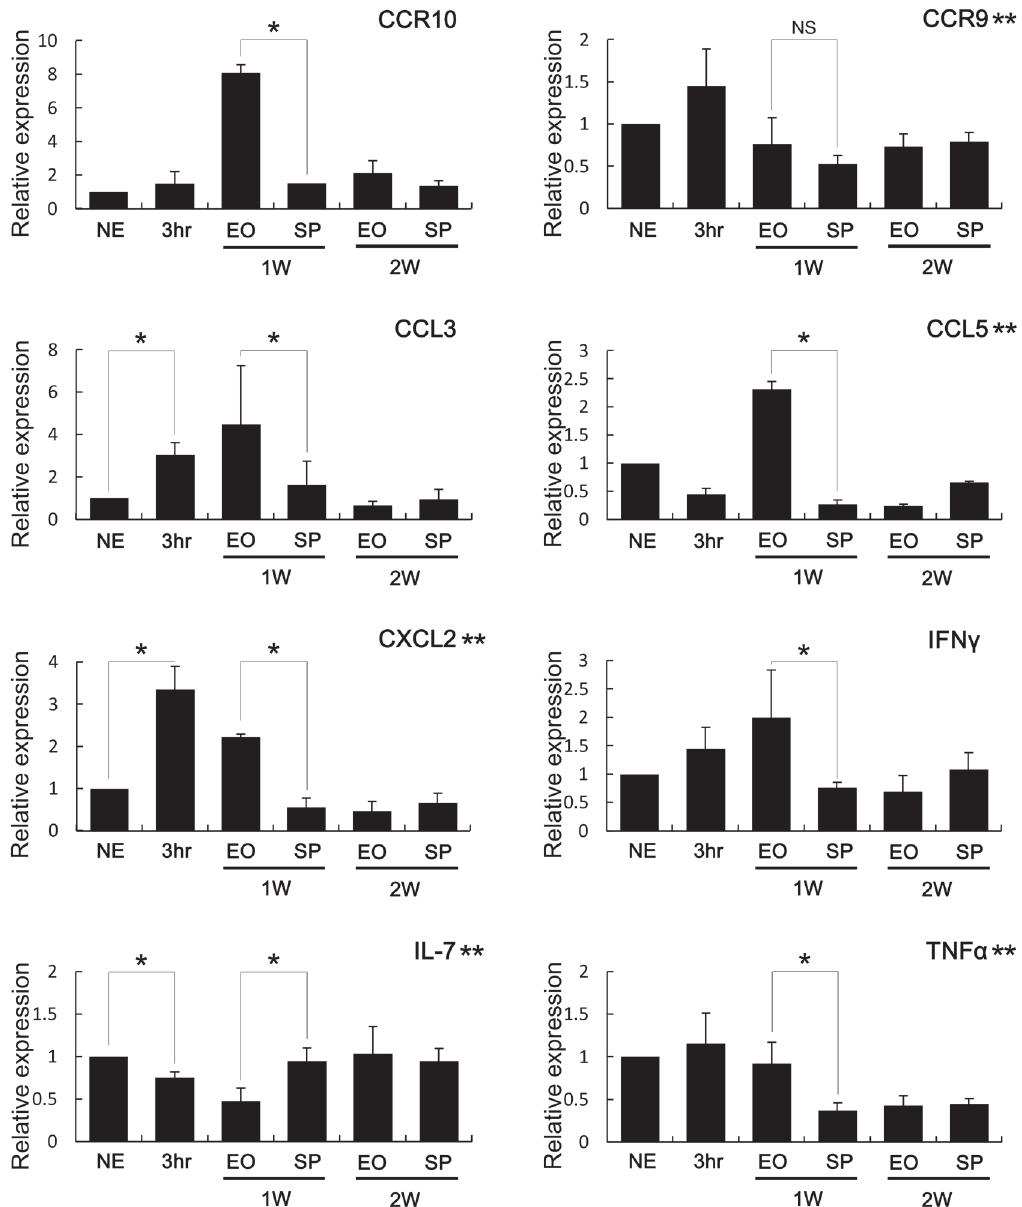
Figure 4- Relative mRNA expression of the indicated chemokines and inflammatory cytokines. Levels of CCR10, CCL3, CCL5, CXCL2, IFN-γ and TNF- α mRNA were significantly higher in the EO group than in the SP group 1 week after tooth extraction (1W). Levels of CCR9 and IL-7 mRNA did not significantly differ between groups. NE: no extraction; 3hr: 3